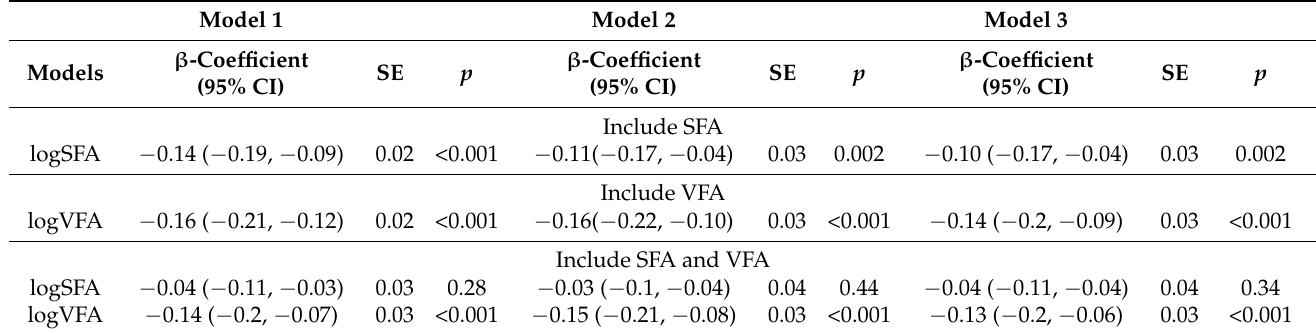
Table 2. Results of multiple linear regression analyses between logSFA, logVFA, and logBNP.